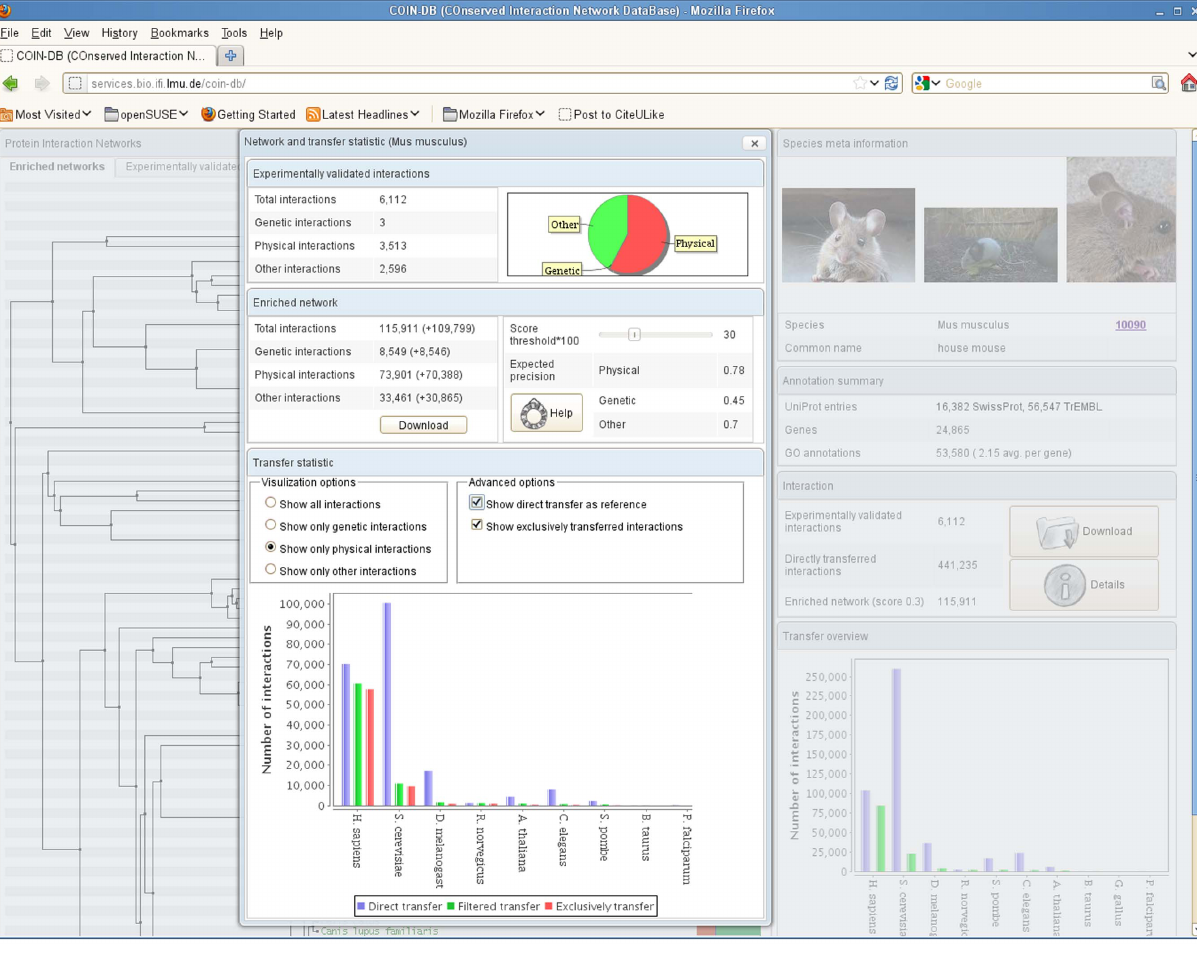
Figure 7. COIN-DB web interface. Screenshot of the web interface for the transferred and scored protein interactions. Transferred and experimentally validated interactions can be downloaded for 83 eukaryotic species for user specified score thresholds. For species of interest the transfer profiles can be inspected in detail including the number of interactions (of the different interaction types) and the number of uniquely transferred interactions, and the expected performance of the